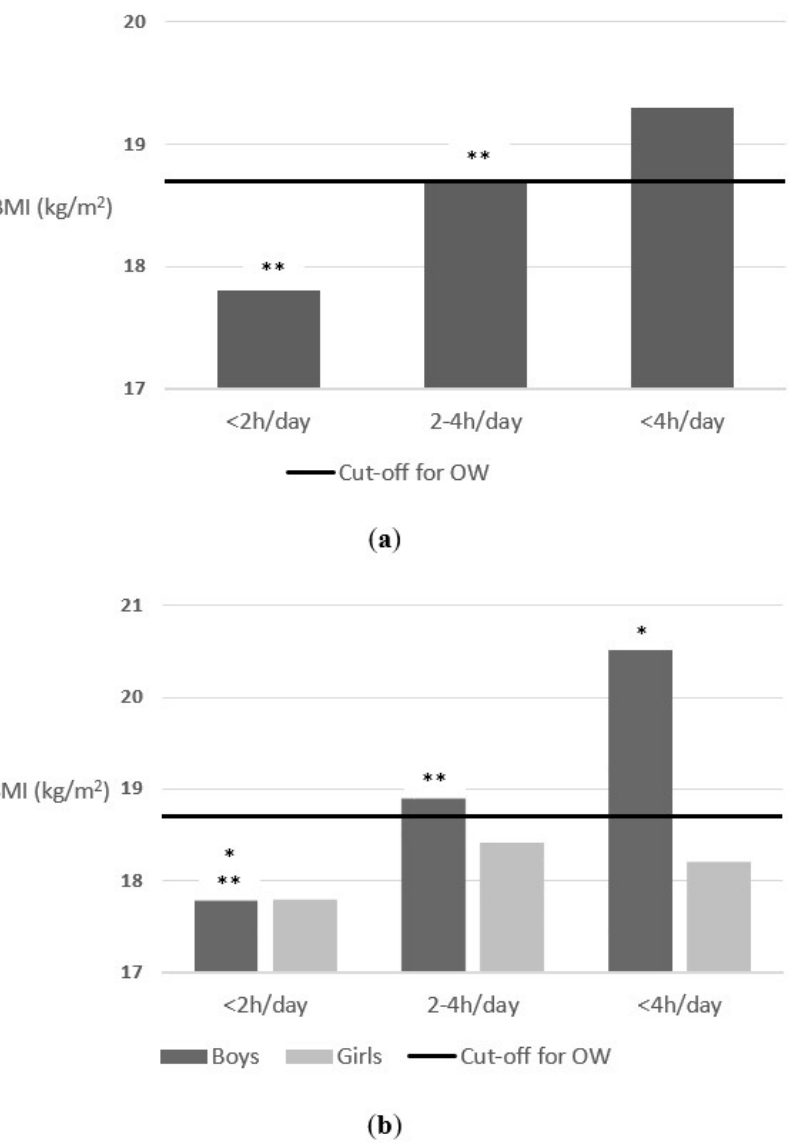
Figure 2. ( a ) Association between time in front of TV on weekends a day and body weight status (parents reported); ( b ) Association between time in front of TV on weekends a day and body weight status (parents reported) segmenting by sex. The cut ‐ off for OW line indicates the beginning of the OW category according to Cole’s cut ‐ off points [44]. * p ‐ value < 0.05 and ** p ‐ value < 0.01. Finally, a positive association was also found between sleep time and body weight status. As can be seen in Figure 3, schoolchildren who slept less than 9 h/between 9 and 11/more than 11 h a day on weekends, had a mean BMI of 20.4, 18.2 and 18.1, respectively, F = 3.2 (2) p = 0.041. However, although the results followed the same trend, no significant results were found when segmented by sex. Boys who slept less than 9 h/between 9 and 11/more than 11 h a day on weekends, had a mean BMI of 21, 18.3 and 17.7,